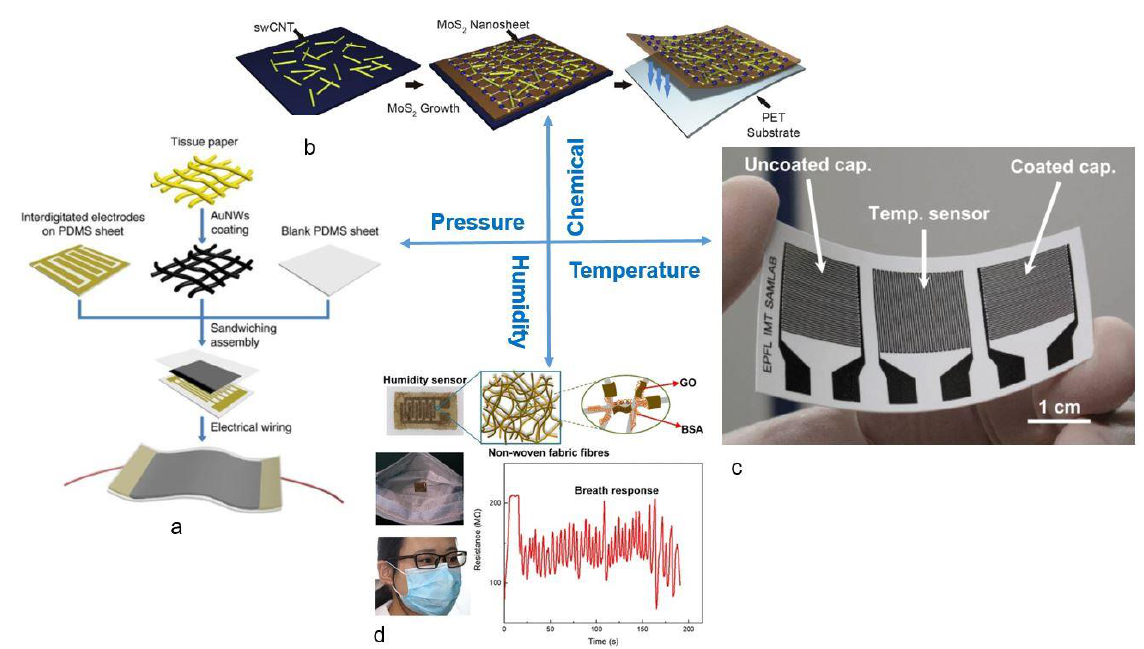
Figure 1. A picture of a collection of types of flexible sensors made from a flexible polymer and nanomaterials as the sensing layer. ( a ) Flexible pressure sensor with Au nanorods intertwined with tissue paper and deposited on PDMS polymer, reprinted with permission from [12]. ( b ) Hydrogen gas sensor with carbon/MoS 2 nanomaterials on PET substrate, reprinted with permission from [13]. ( c ) Silver nanoparticles inkjet printed on paper to fabricate a flexible temperature sensor, reprinted with permission from [14]. ( d ) Graphene Oxide deposited on fabric for humidity sensing, reprinted with permission from [15].